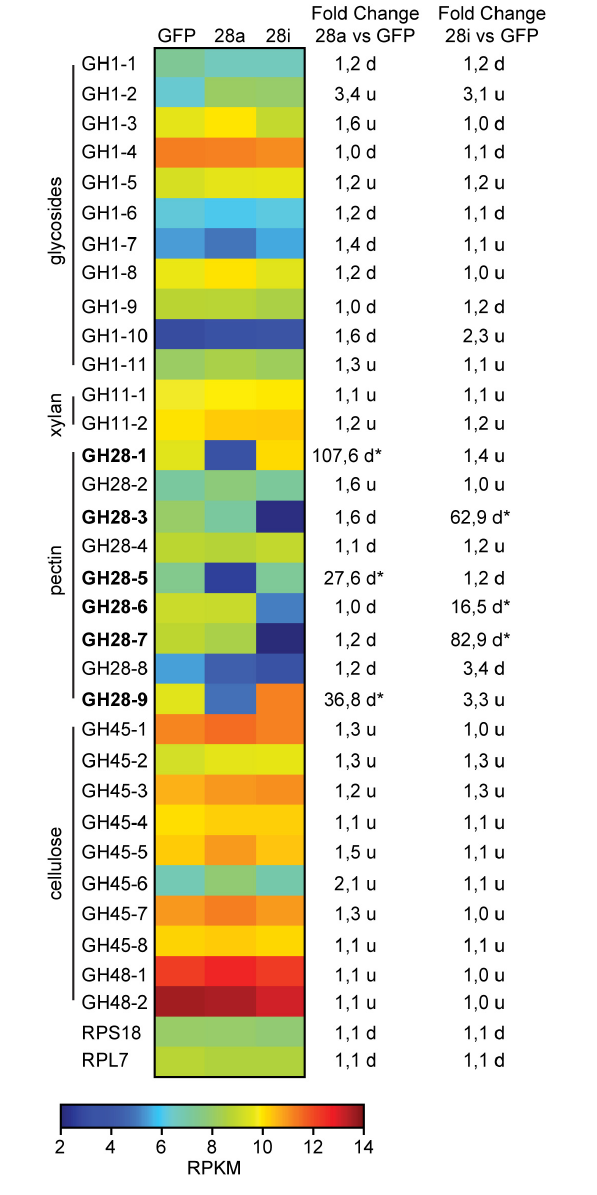
FIGURE 2 | Heat map showing the relative expression levels of different glycoside hydrolase families (GH1 to 48) comparing the injection control (GFP) with the active (28a) and inactive (28i) GH28-silenced P . cochleariae larvae. Substrates of the different GH families are on the left. Silencing targets are indicated in bold and significant differences are shown with an asterisk ( ∗ < 0.05). Ribosomal protein 7 (RPL7) and ribosomal protein S18 (RPS18) are shown to confirm the uniform expression of these housekeeping genes across treatments. The map is based on log2-transformed RPKM values (blue represents weakly expressed genes, and red represents strongly expressed genes). The fold-change values presented on the right side were calculated based on the log2-transformed RPKM values.